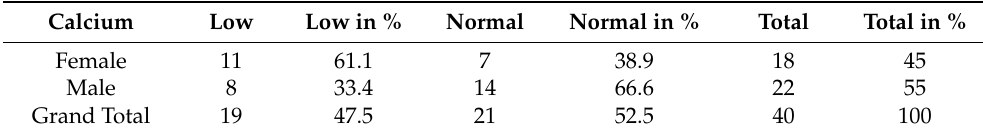
Table 1. The relation of serum (calcium) with COVID-19 infection.